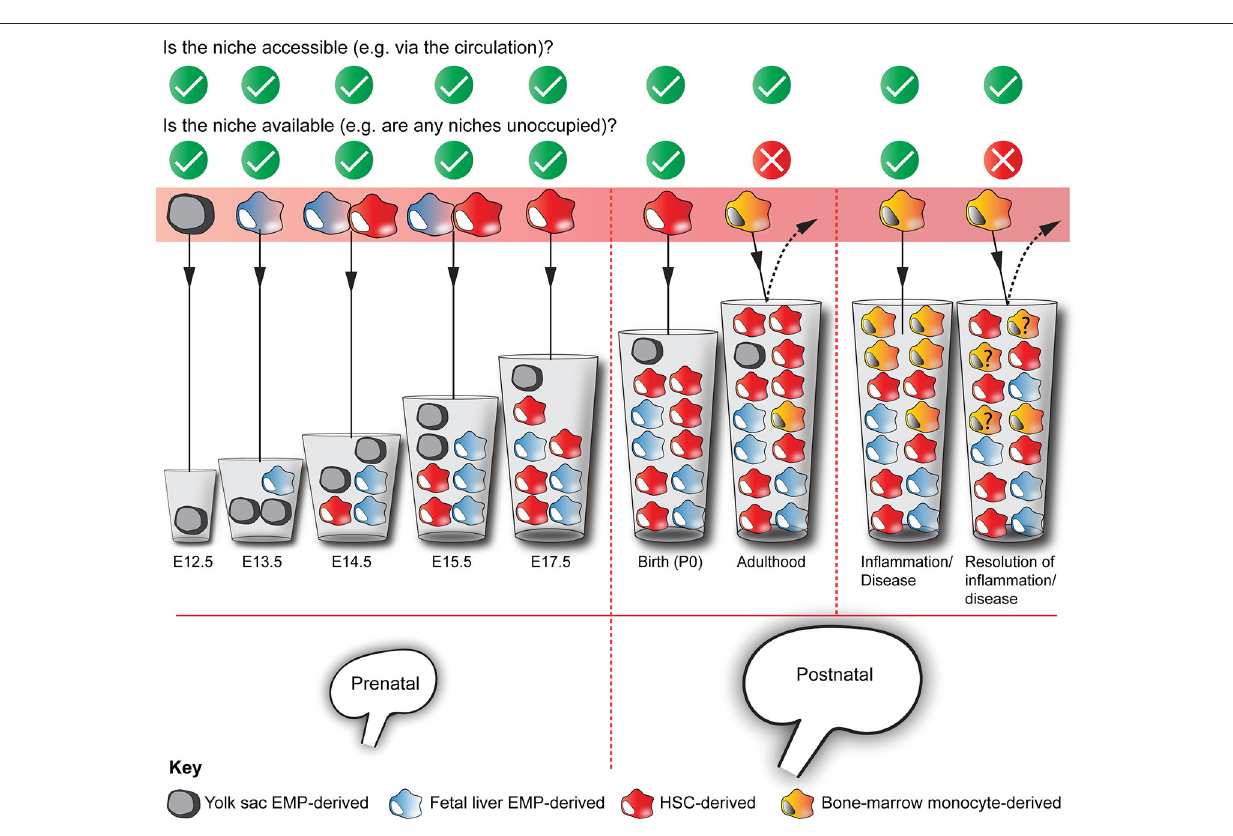
no monocytes (CD45 + CD11b hi F4/80 lo Ly6C + cells) are